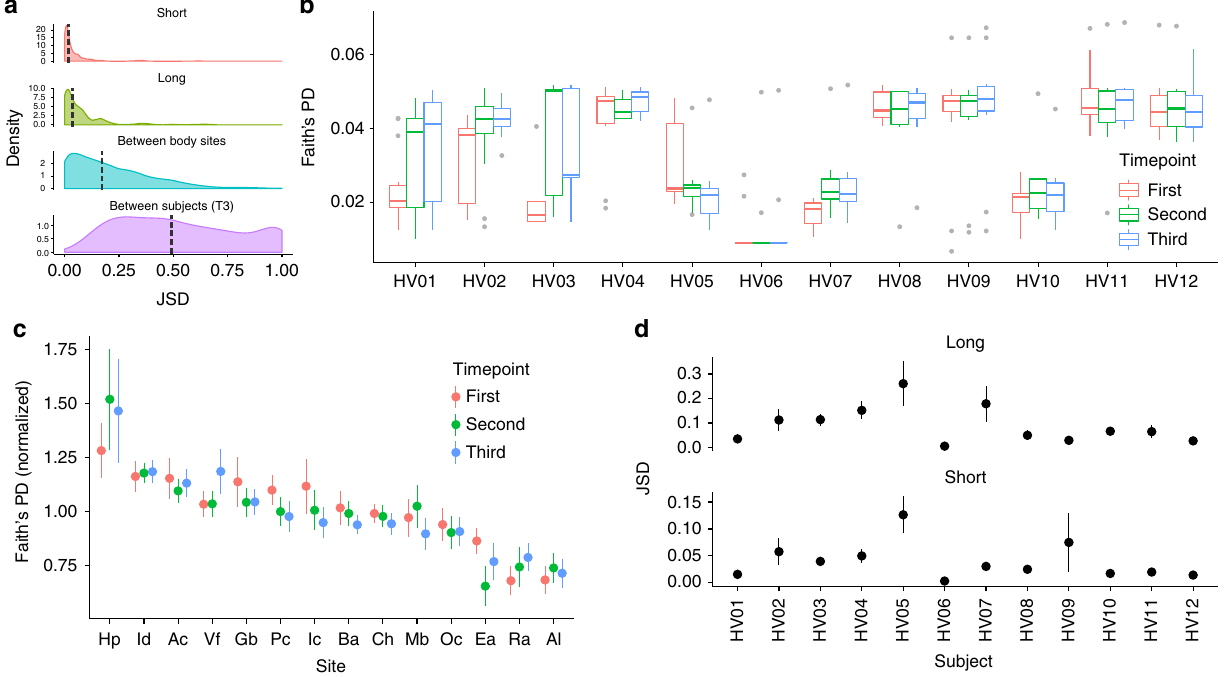
pletely absent from the supragingival plaque. These fi ndings were re fl ected in the phylogenetic diversity of the Neisseria population of samples from the three sites, that was signi fi cantly higher in the supragingival plaque than in the buccal mucosa (FDR corrected P = 1.2×10 − 6 , Wilcoxon rank-sum test), and in the tongue dorsum ( P = 3×10 − 7 ). An analysis of the Jensen – Shannon Divergence